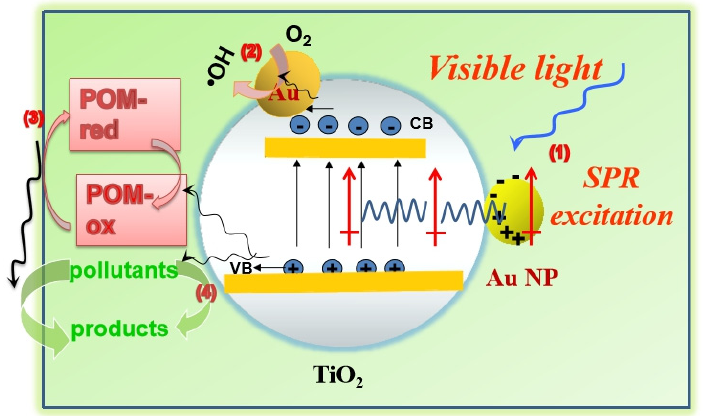
Scheme 1. Schematic illustration of the mechanism for the photocatalytic oxidation of pollutants (such as phenol) on the AuPT photocatalyst